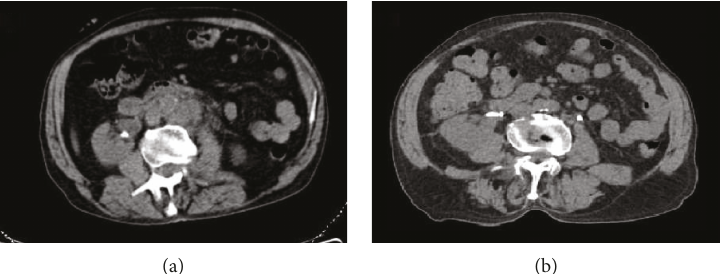
Figure 2: Computed tomography (CT) images (a) before and (b) after 3 administrations of atezolizumab showing a signi fi cant decrease in the size of lymph nodal